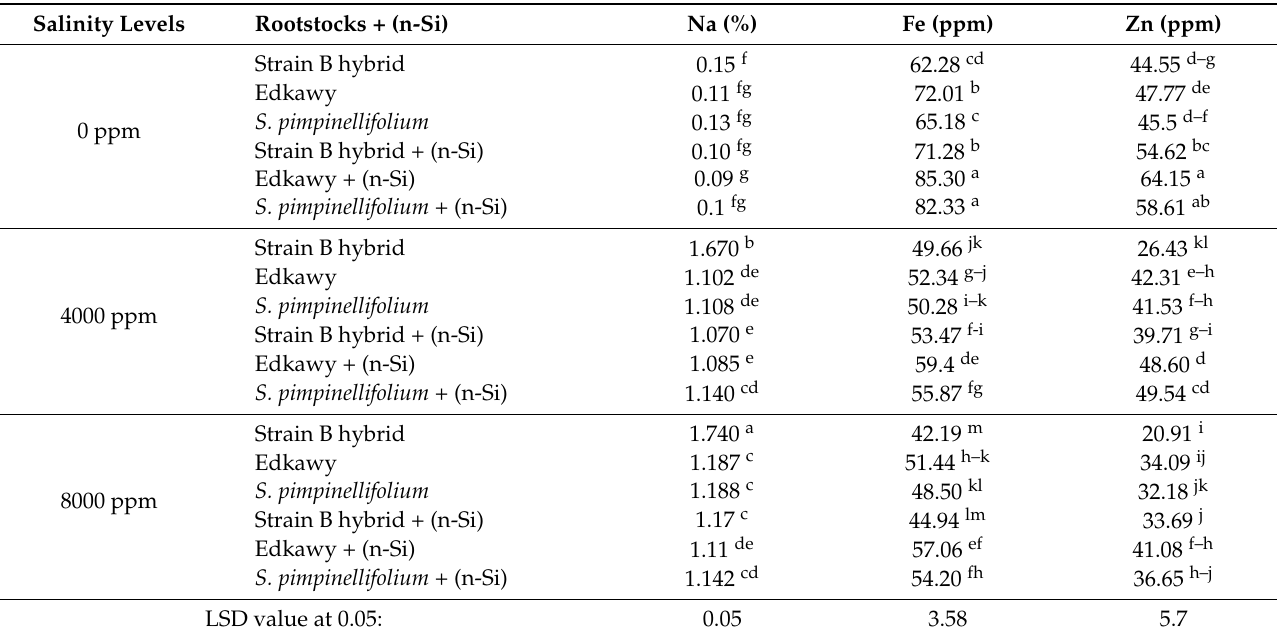
Table 4. Effect of water salinity, grafting, and foliar application of (n-Si) interactions on minerals of tomato shoots (combined 2020 and 2021